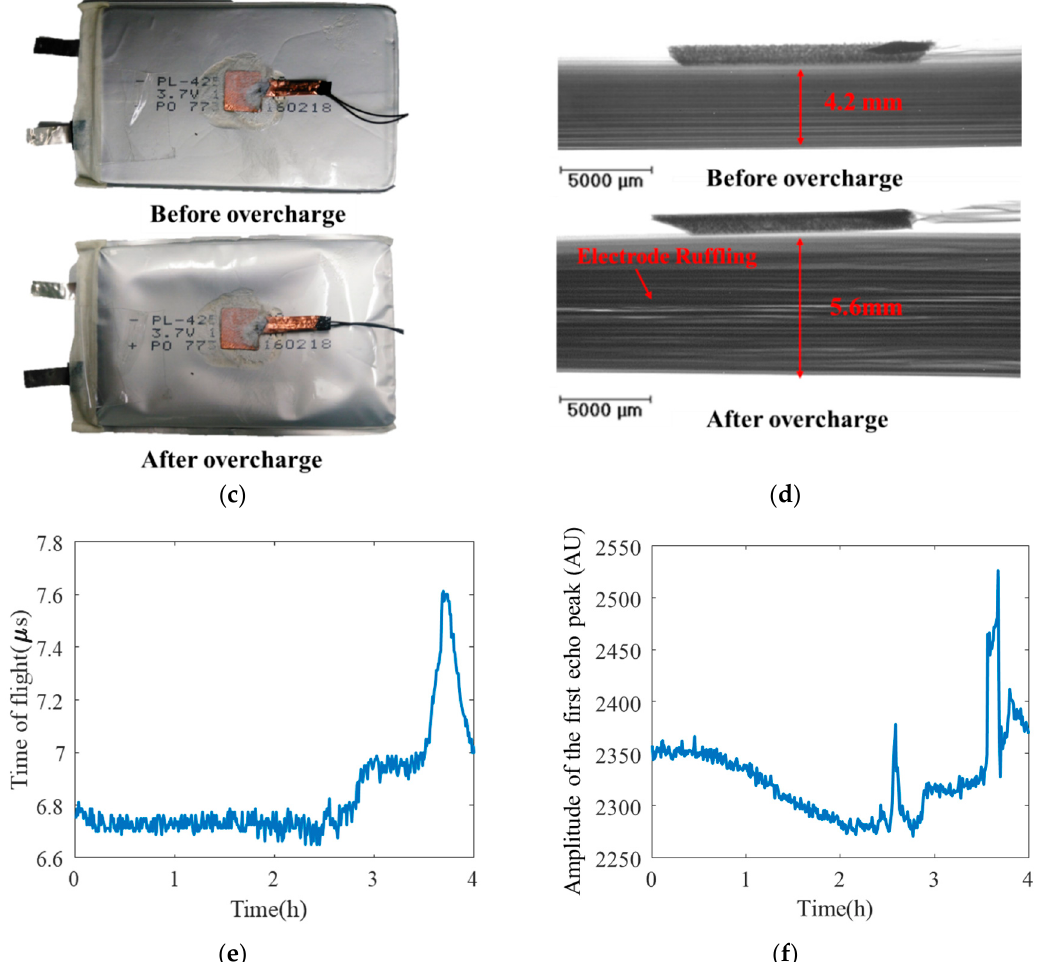
Figure 7. Overcharge test results for battery A1: ( a ) voltage and current profiles, ( b ) temperature profile, ( c ) photos of the battery (top view), ( d ) X-ray images of the battery (side view), ( e ) evolution of TOF, and ( f ) evolution of PA.